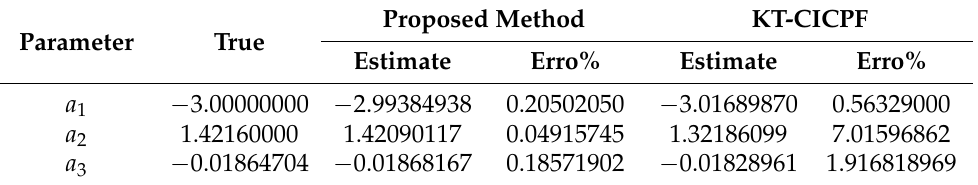
Table 3. The motion parameter estimation results of the point target obtained by the two methods. Proposed Method KT-CICPF Parameter True Estimate Erro% Estimate